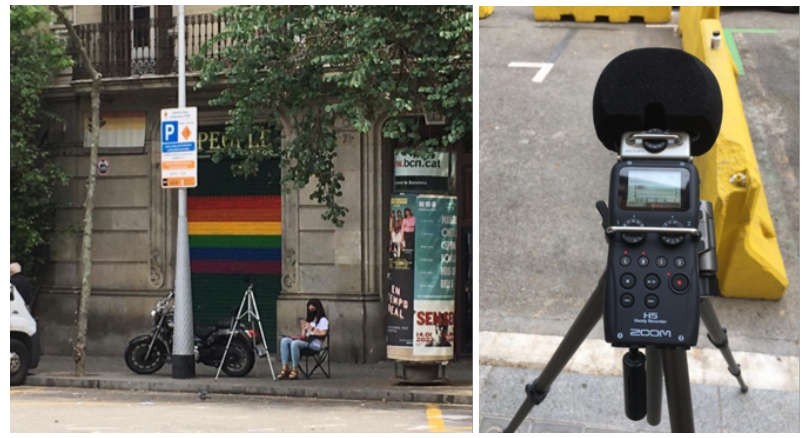
Figure 1. Recording campaign and Zoom